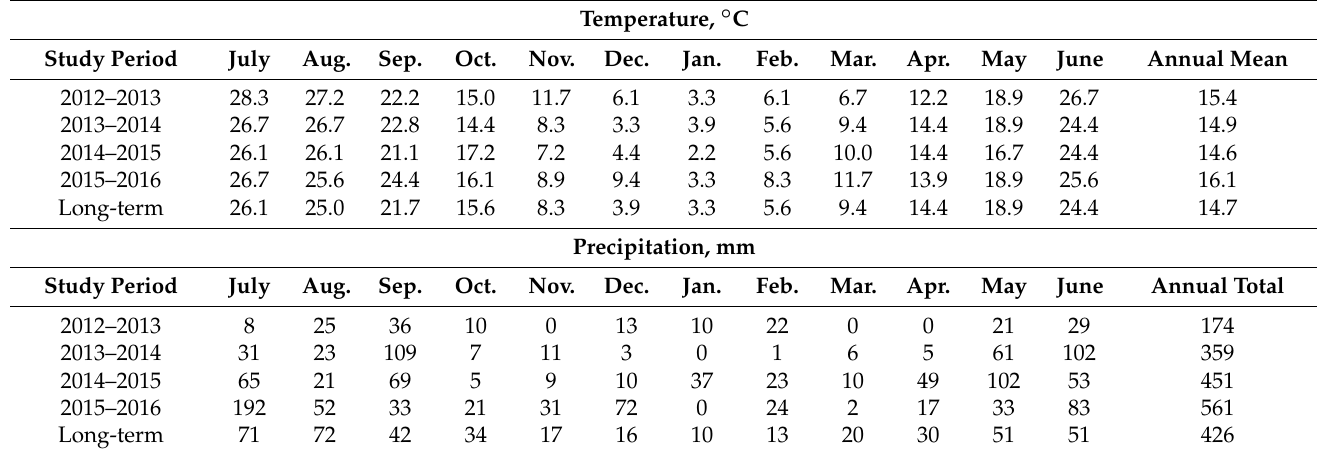
Table 2. Monthly mean air temperatures and total precipitation at Tucumcari, NM, USA, during the study and intervening periods and the long-term means or totals